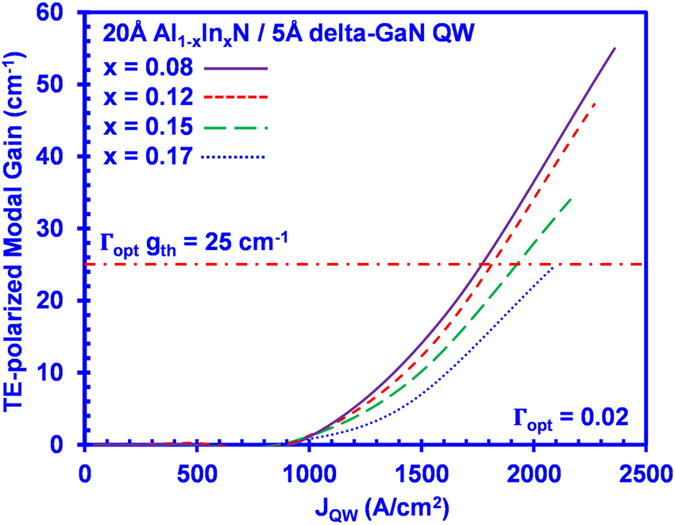
Peak TE-polarized modal gain as a function of current density in the active region (JQW = Jrad + Jnon-rad) for 20 Å Al1–xInxN/5 Å delta-GaN QW.